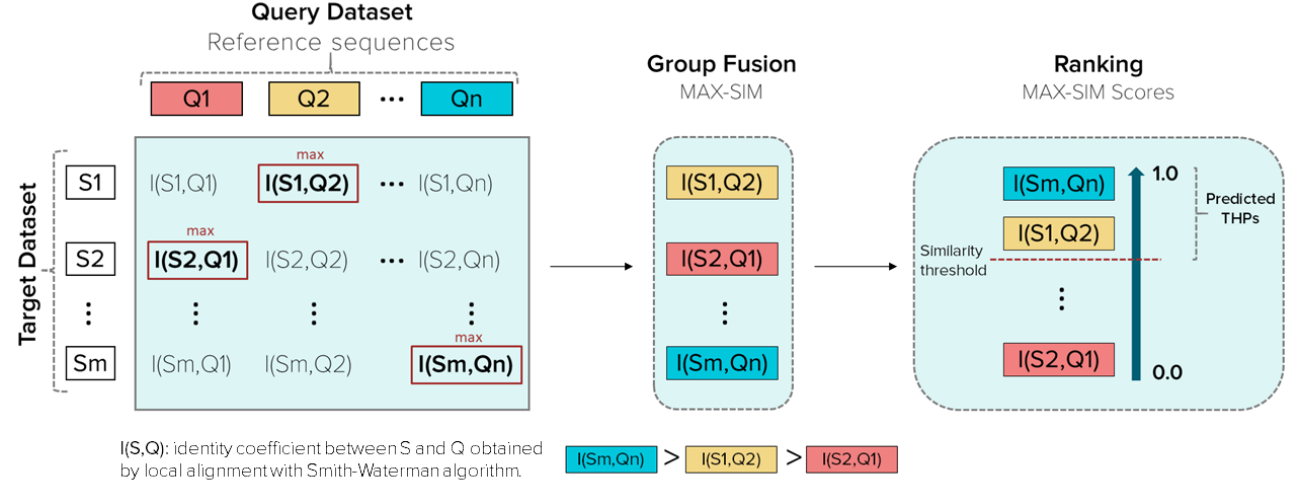
Figure 2. Schematic representation of the group fusion and similarity searching processes. Q is a peptide from a query dataset, n is the number of peptides contained in a query dataset, S is a peptide from the target dataset (Main, Small, or Main90 dataset), m is the number of peptides included in the target dataset (1302, 938, or 619, respectively). The similarity threshold is related to the percentage of identity.